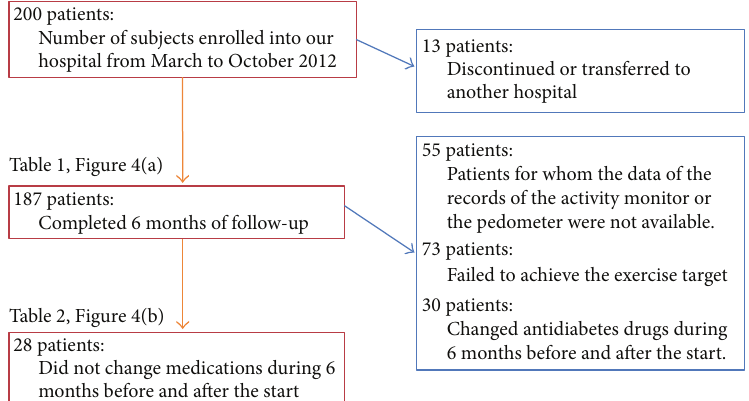
Figure 3: Patient selection process. After excluding those patients who cancelled, transferred to other hospitals, or dropped out, the data of 187 patients were subjected to analysis. After excluding patients with insufficient exercise therapy record data, unachieved exercise goals, and changes in medications in the 6 months before and after the start of the study period, data of 28 patients of each group were compared and studied.